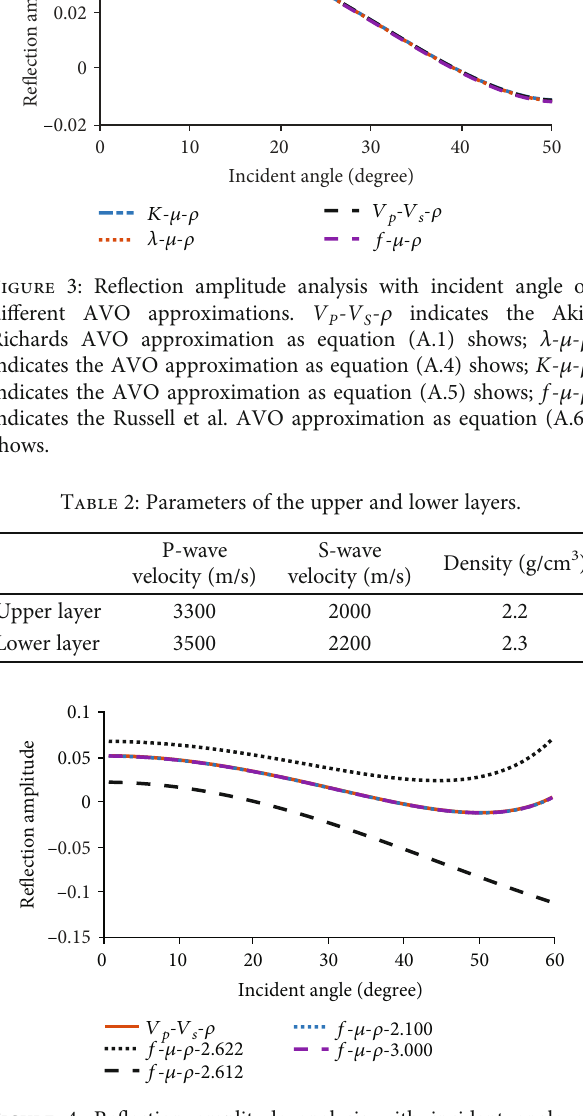
Figure 4: Re fl ection amplitude analysis with incident angle of di ff erent γ 2 dry . V P ‐ V S ‐ ρ indicates the Aki-Richards